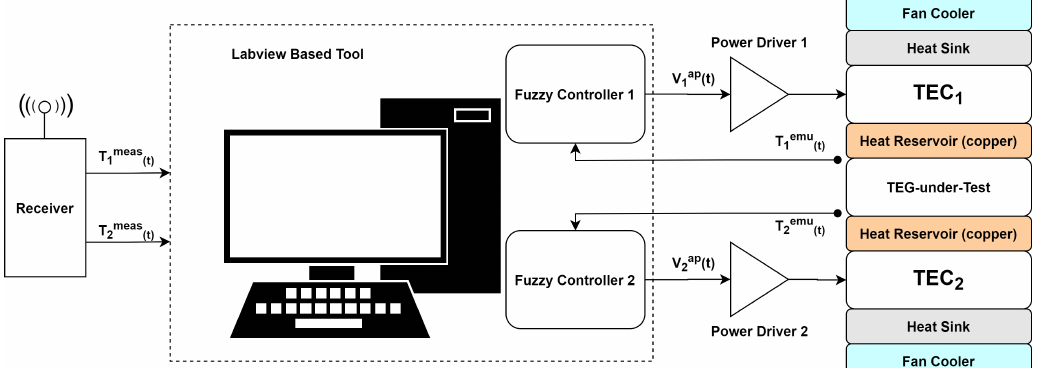
Figure 2. Thermal emulation system block